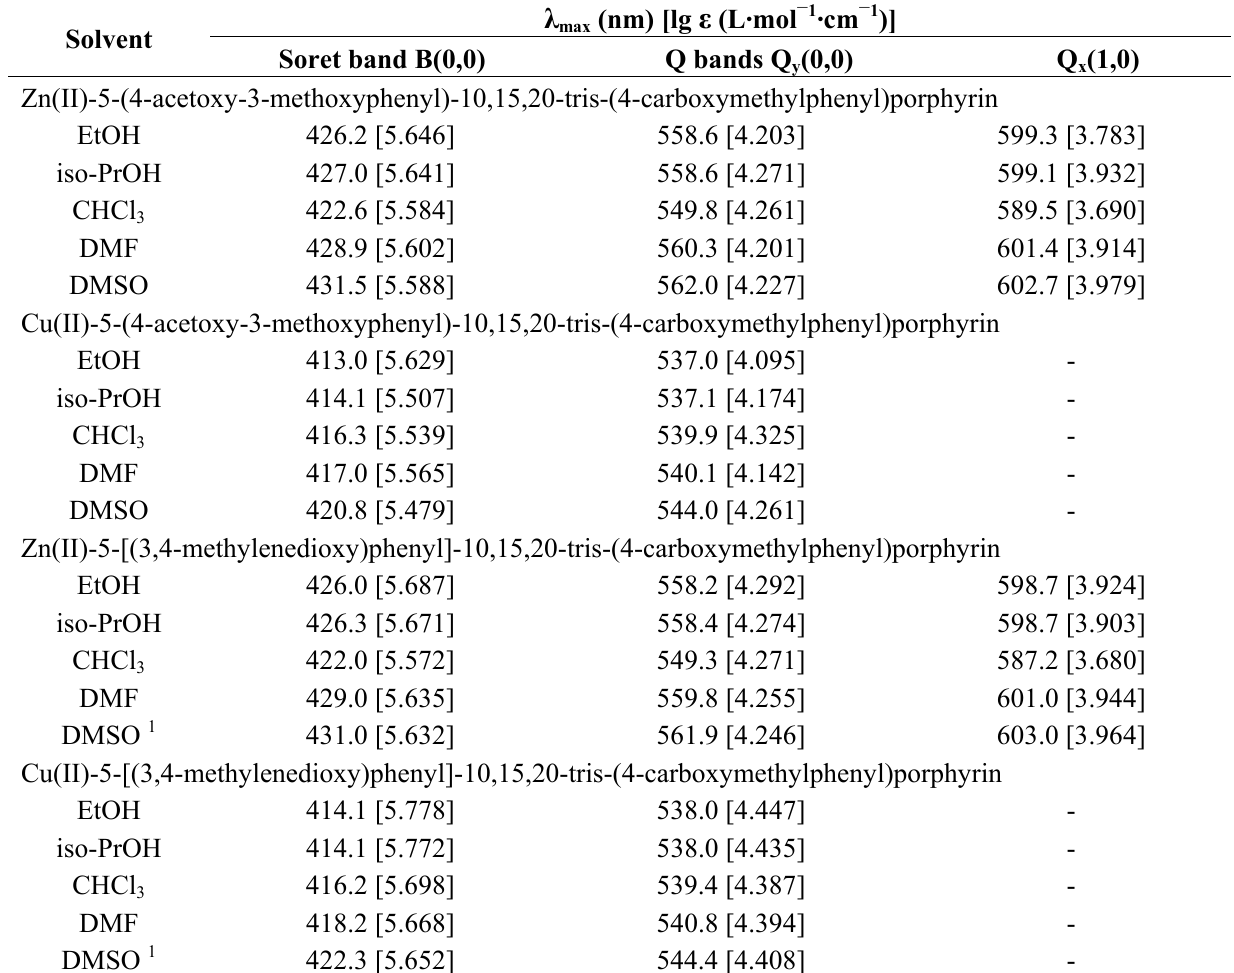
) and molar absorptivity values (lg ε ) for max